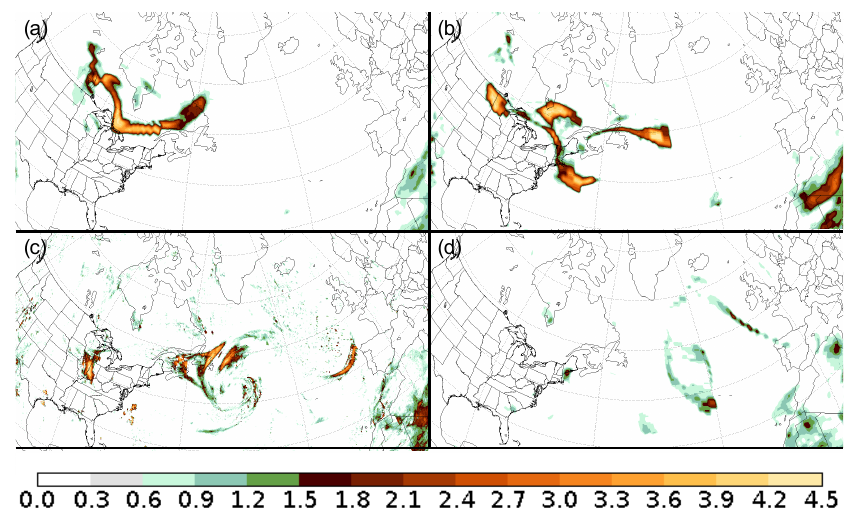
Figure 13. OMPS Aerosol Index for sections of the S-NPP orbits at 05:00UTC on (a) 19, (b) 20, (c) 21 and (d) 22 May. Images courtesy of Colin Seftor.